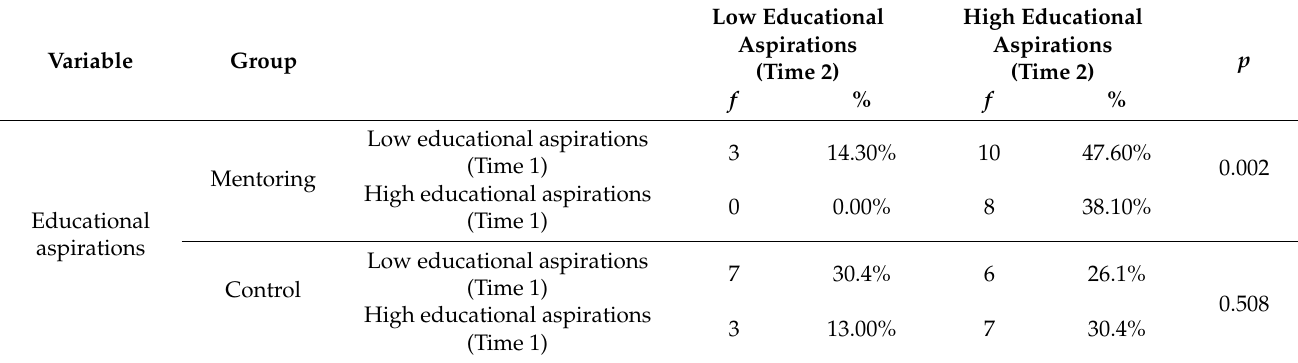
Table 3. Participation in the mentoring program and educational aspirations: the McNemar test.